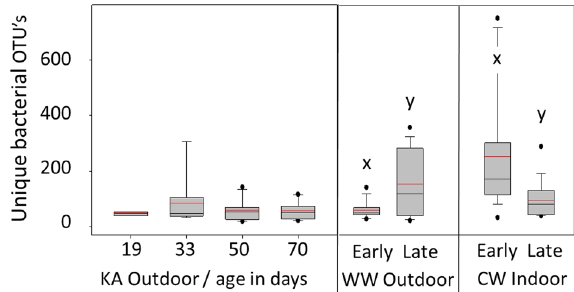
Figure 2. Bacterial diversity in midguts of worker bees depicted as the number of amplicon sequence variants or unique OTUs. Known age (KA) bees did not differ in diversity by age class from early to late winter. Diversity increased significantly in the warm winter (WW) outdoor environment (t 30 = 2.89, p = 0.007) and decreased significantly in the cold winter (CW) indoor environment (t 32 = 2.89, p = 0.008). Grey boxes contain 50% of the variation, whiskers contain 90%, and the dots represent the range. The horizontal red bar is the mean and black is the median. Boxplots created with SigmaPlot (Systat Software, San Jose,